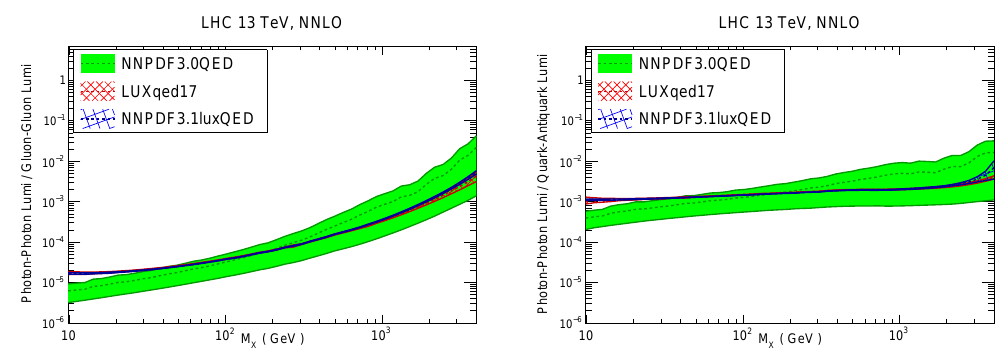
/ (left) and γγ L L gg